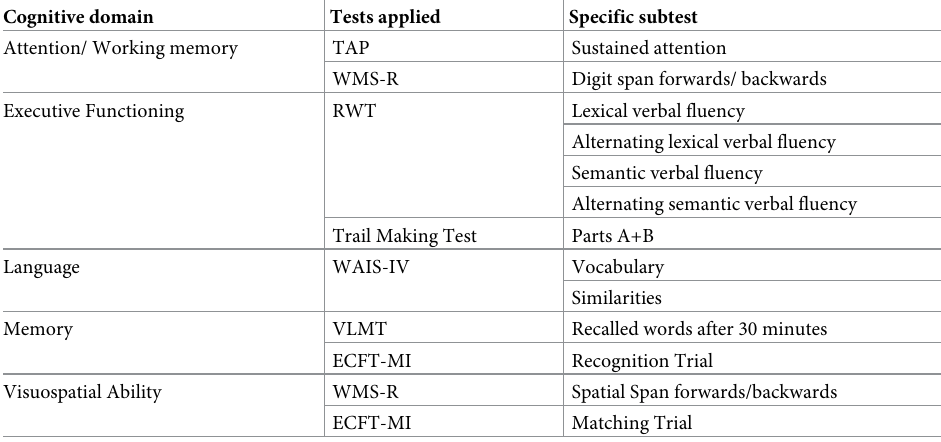
Table 1. Overview of the applied neuropsychological tests.